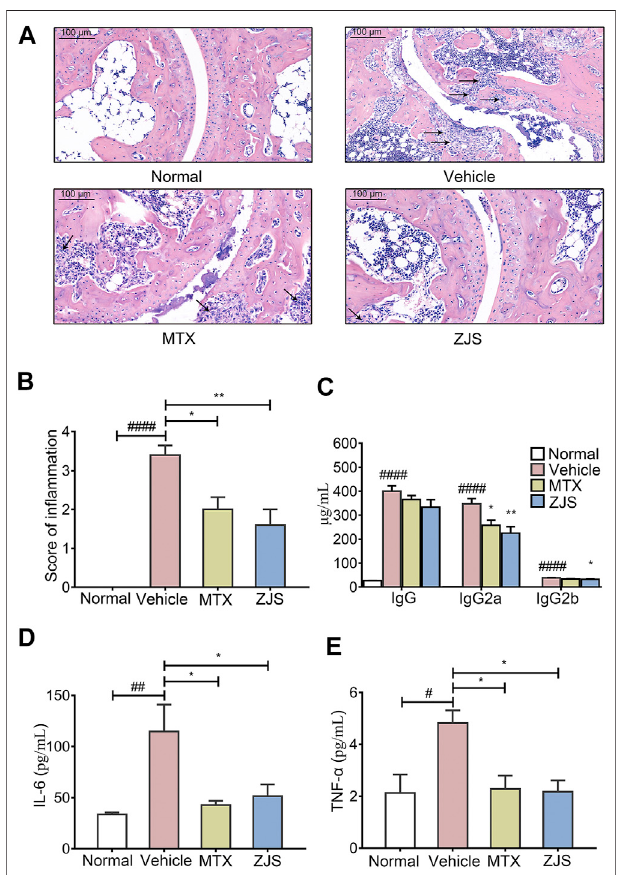
FIGURE 2 | ZJS inhibited cartilage damage, anti-CII speci fi c Abs production, and in fl ammatory cytokines in CIA mice. (A) Representative pathological images of ankle joints stained with HE, the arrows indicated the synovial cell hyperplasia in the pathological images of ankle joints (scale bar (cid:1) 100 μ m). (B) Thepathologicalassessmentofanklejointsintheindicated groups ( n (cid:1) 5). (C) The levels of anti-bovine CII-speci fi c IgG and isotype- speci fi c IgG2a and IgG2b antibodies in mouse serum ( n (cid:1) 5). (D,E) The levels ofpro-in fl ammatorycytokines(IL-6andTNF- α )inmouseserum( n (cid:1) 5).Values are presented as the mean ± SEM. # p < 0.05, ## p < 0.01, #### p < 0.001, compared with the normal group. * p < 0.05, ** p < 0.01, compared with the vehicle group (One-way ANOVA test).